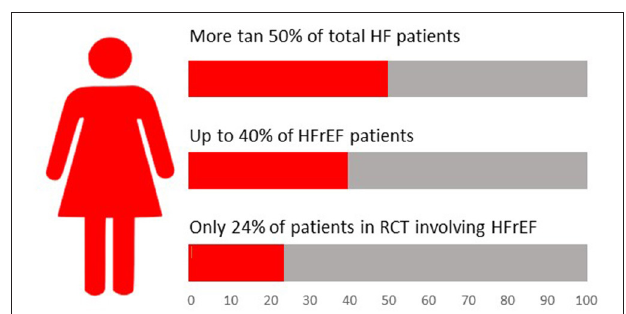
FIGURE 2 | Relevance of female sex in heart failure landscape. HF, Heart Failure; HFrEF, Heart Failure reduced Ejection Fraction; RCT, Randomized Controlled